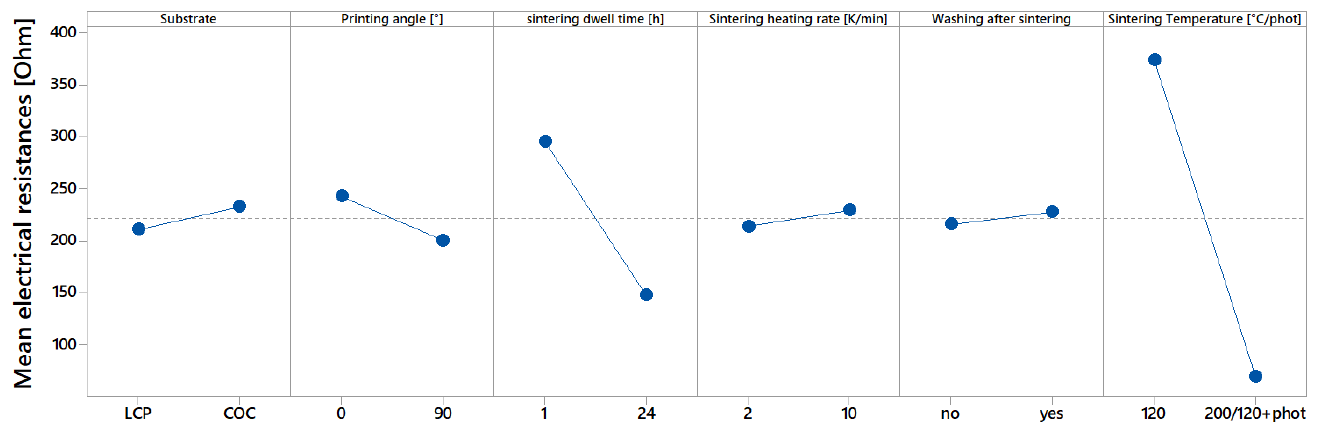
Figure 7. Main effect diagram, which indicates influences of manufacturing parameters on electrical conductivity.